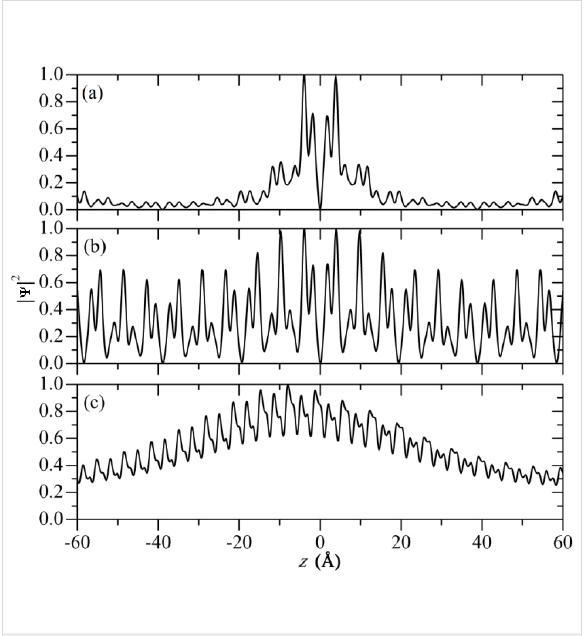
Figure 6: One-dimensional electron probability distribution | Ψ ( r e ; r h )| 2 in real space of the first excitonic state (the first absorption peak) of silicon nanotubes (4,4) (a), (6,6) (b) and (10,0) (c). This one-dimen- sional distribution is plotted along the tube axis ( z ) with the hole posi- tion r h fixed at zero; the other coordinates are integrated